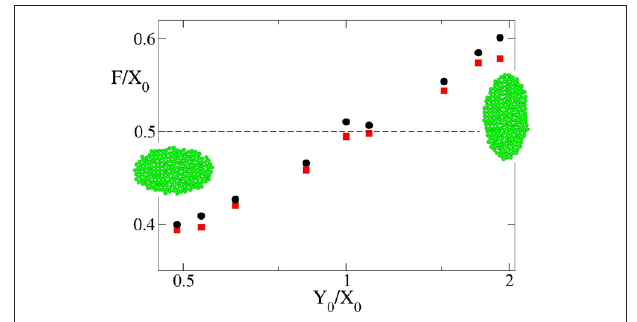
FIGURE 6 | Dependence of the highest and lowest value of ˜ F = F / X 0 for which eye growth termination does not occur (red square) or does take place (black circles) with the shape of the primordium indicated as Y 0 / X 0 as obtained by computer simulation. In all the cases v gr = 6 σ/τ . The snapshots are typical examples of primordia with X 0 > Y 0 and X 0 > Y 0 . An example of the case X 0 = Y 0 is shown in Figure 3 . The dashed line is the theoretical limiting value ˜ F = F / X 0 =